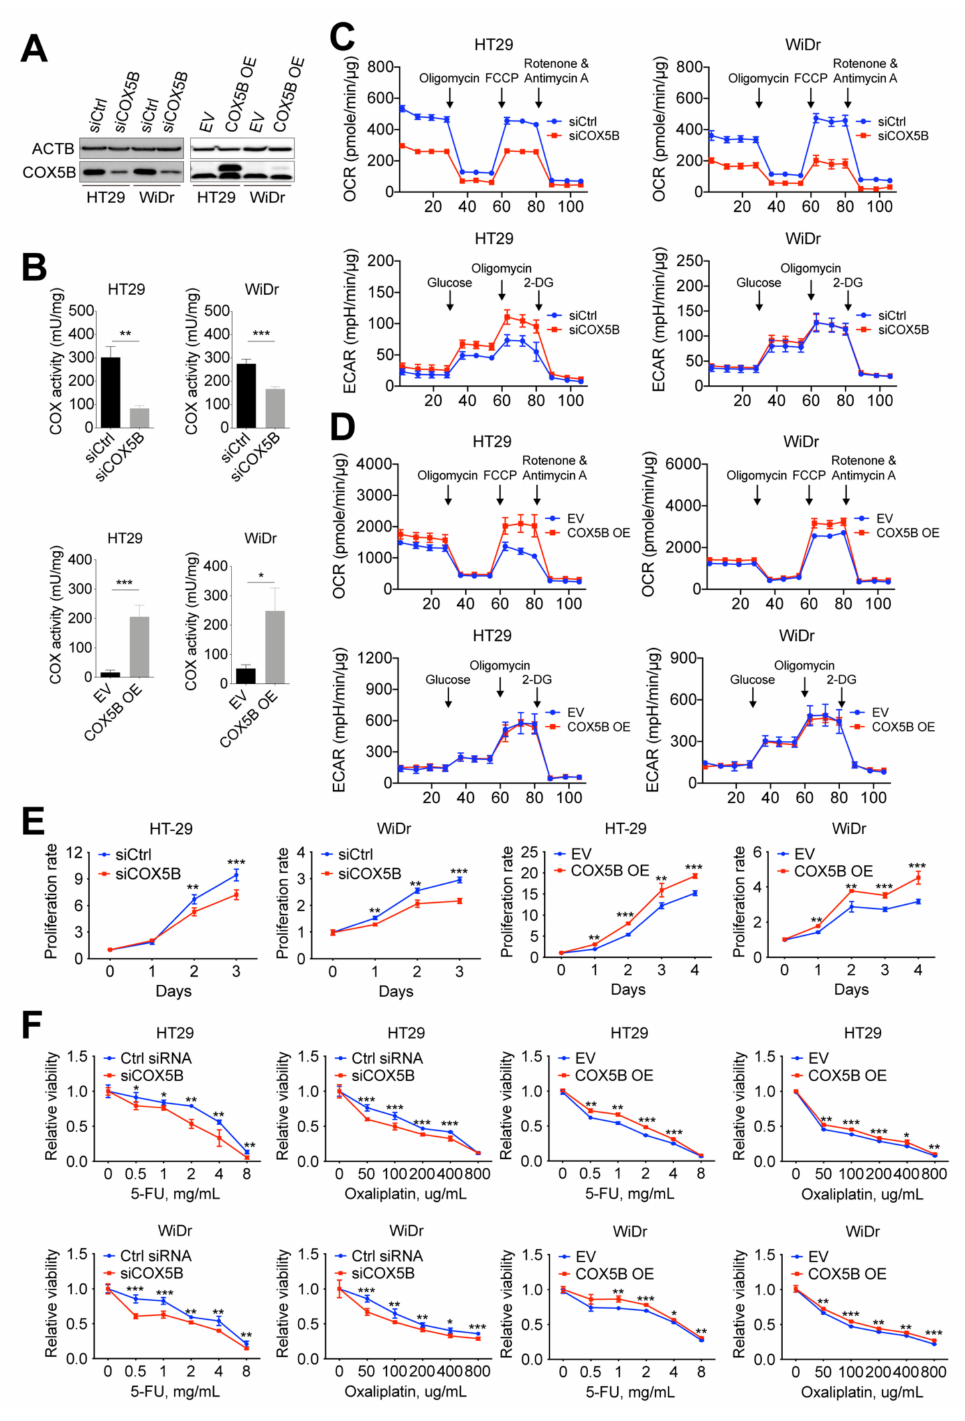
Figure 3. Change of COX5B expression affects bioenergetic alterations, cell growth, and sensitivity to anticancer drugs in CRCs cells. ( A ) The representative images of Western blot analysis. ( B ) The results of COX activity assay of CRCs cells with indicated treatments. COX, cytochrome c oxidase. The results of Seahorse assay of CRCs cells with silencing ( C ) or overexpressing COX5B ( D ). The proliferation ability ( E ) and sensitivity to anticancer drugs under indicated concentrations ( F ) in CRCs cells with either silencing or overexpressing COX5B were shown. *, p < 0.05; **, p < 0.01; ***, p < 0.001. All the p values were acquired by two-tailed paired Student’s t